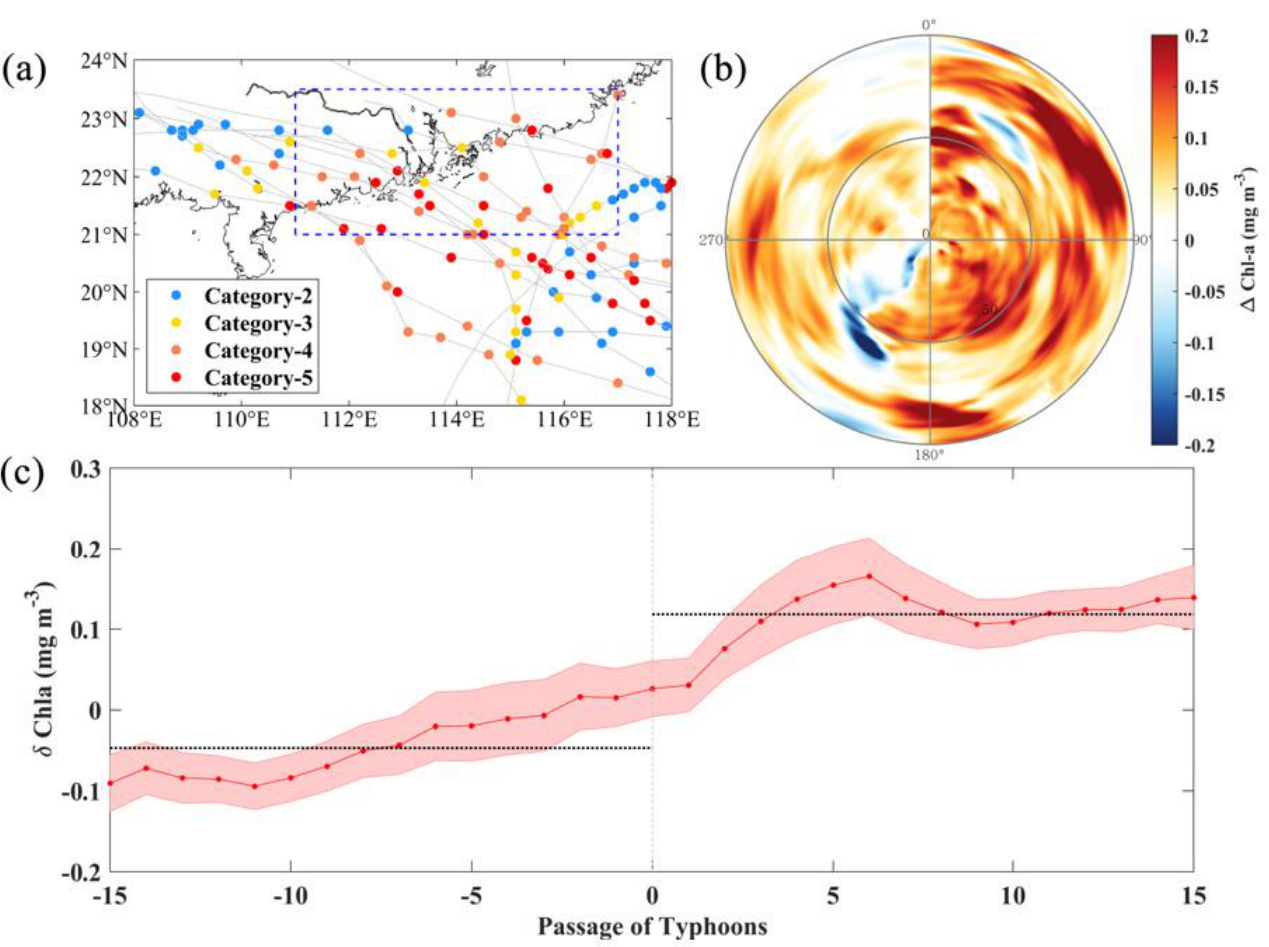
Figure 13. ( a ) Maps of the typhoon transits in the PRE; ( b ) composite of the typhoon−induced changes in the surface C chla (Δ Chla , mg · m −3 ); ( c ) daily spatial averages of C chla anomalies (δ Chla , mg · m −3 ) before and after the arrival of the typhoon. The shading red patch is standard errors within each day, and the black dotted lines are the average of anomalies before and after typhoons.